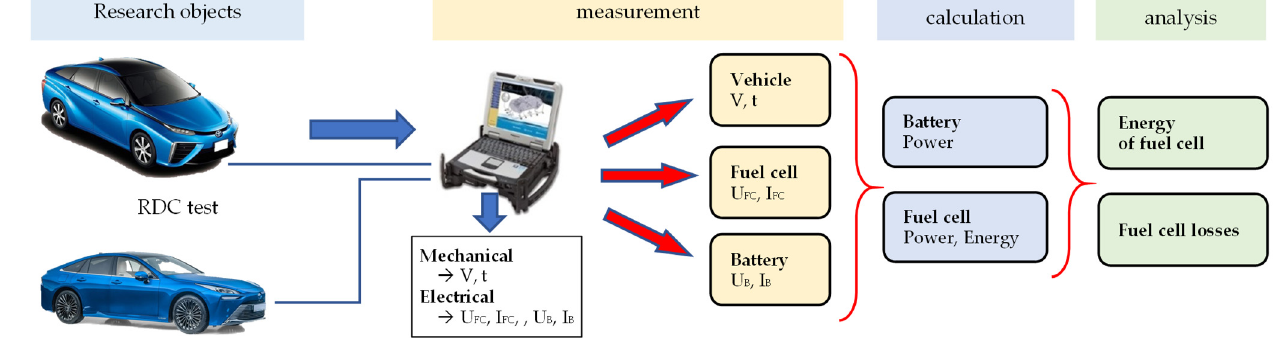
Figure 10. Methodology of testing vehicles powered by fuel cells (data sampling frequency: 1